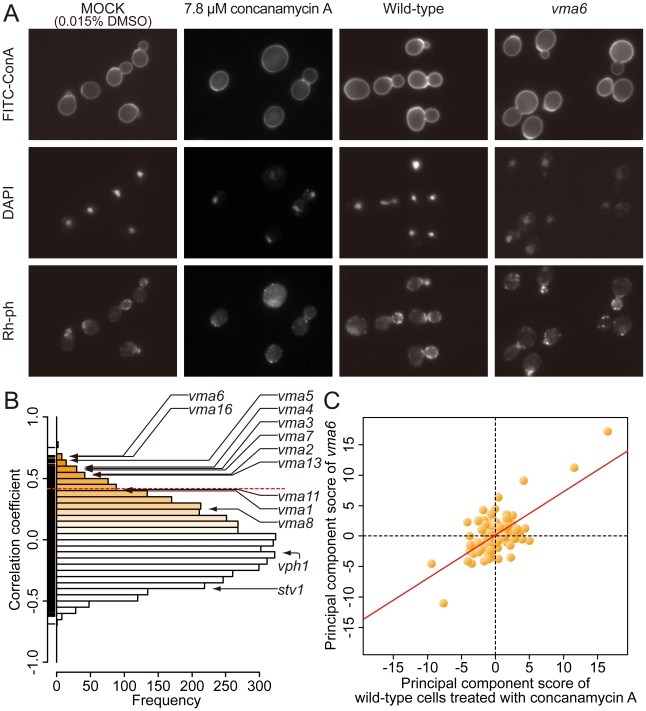
Concanamycin A treatment and the results of target inference.A) Photographs of wild-type cells treated with 7.8 µM concanamycin A and the vma6 mutant. Cells were triply stained with FITC-ConA, Rh-ph, and DAPI. Quantitative analysis of concanamycin A-induced morphologic changes is summarized in Table S2. B) A histogram of correlation coefficients (R) between mutant and concanamycin A-treated wild-type cells. The dashed red line indicates the position of the R value corresponding to the two sided P value of 0.05 with the Bonferroni correction based on a correlation coefficient test. C) Two-dimensional plot of concanamycin A-treated wild-type cells and the vma6 mutant. Scores for the 104 principal components are plotted. The red line represents a linear regression model (R = 0.685).